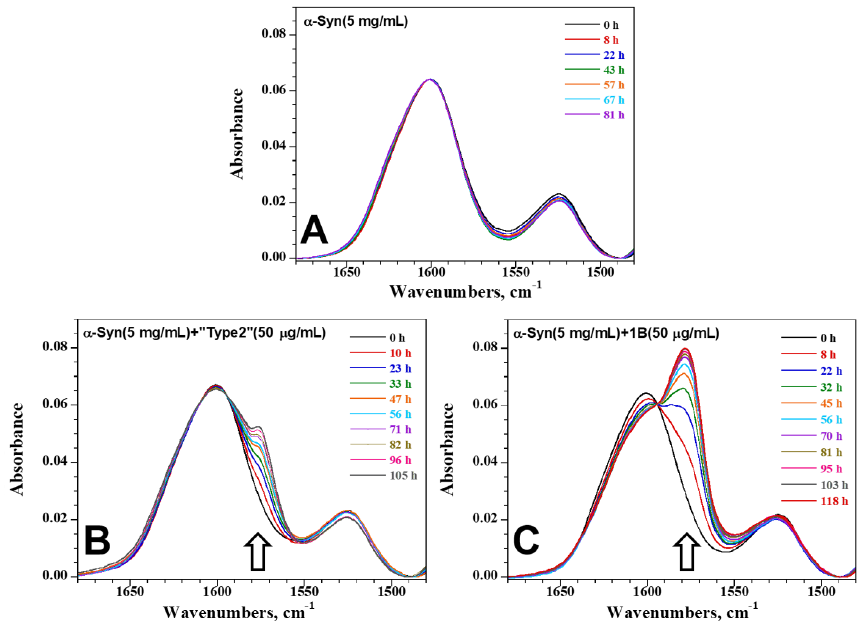
Figure 2. Time lapse of the IR spectra of monomeric α -Syn: ( A ) without seeding, ( B ) seeded with 1% of “Type 2” fibrils, or ( C ) seeded with 1% of 1B fibrils.